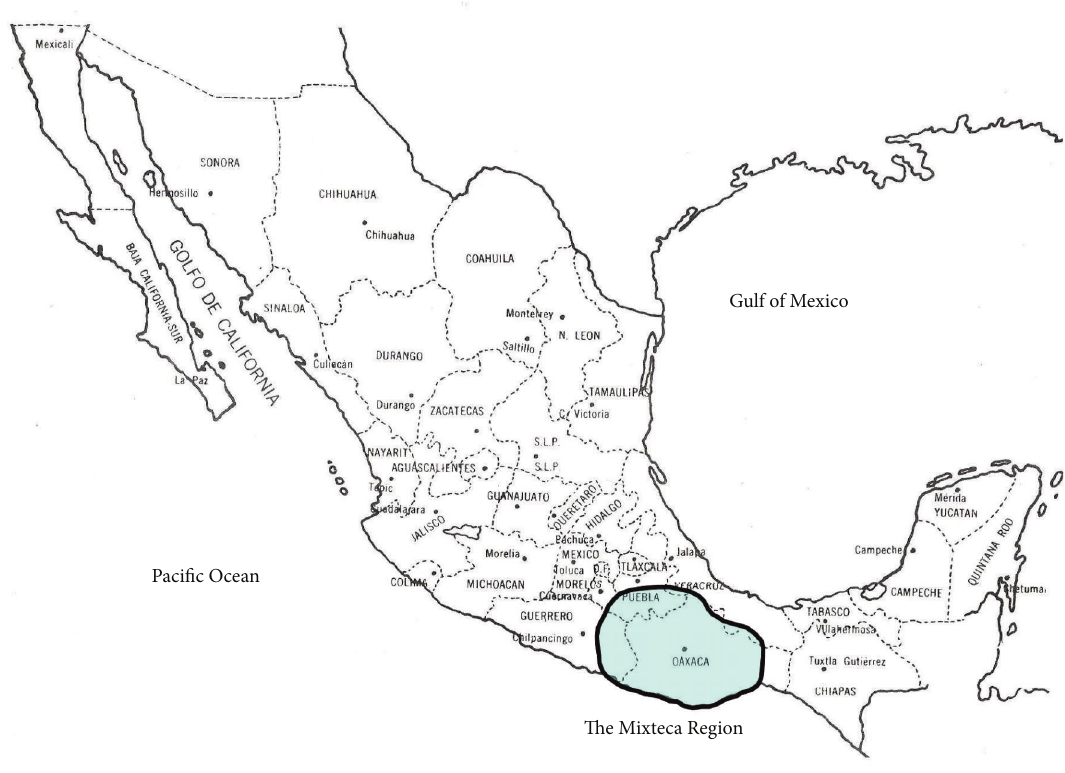
Figure 1: Mixteca Region within the Mexican